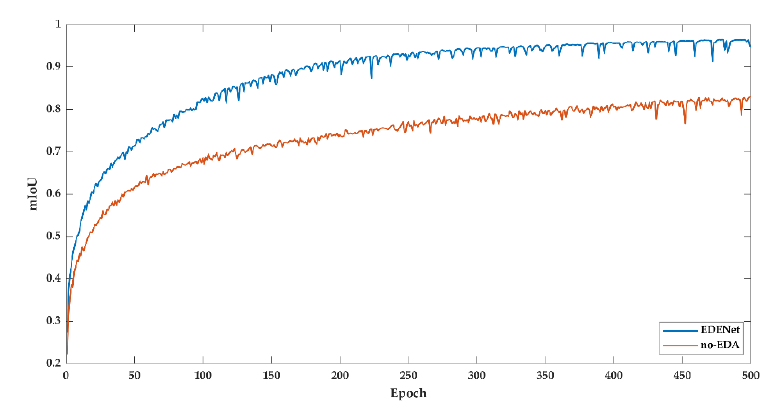
Figure A3. Training loss of Potsdam dataset.